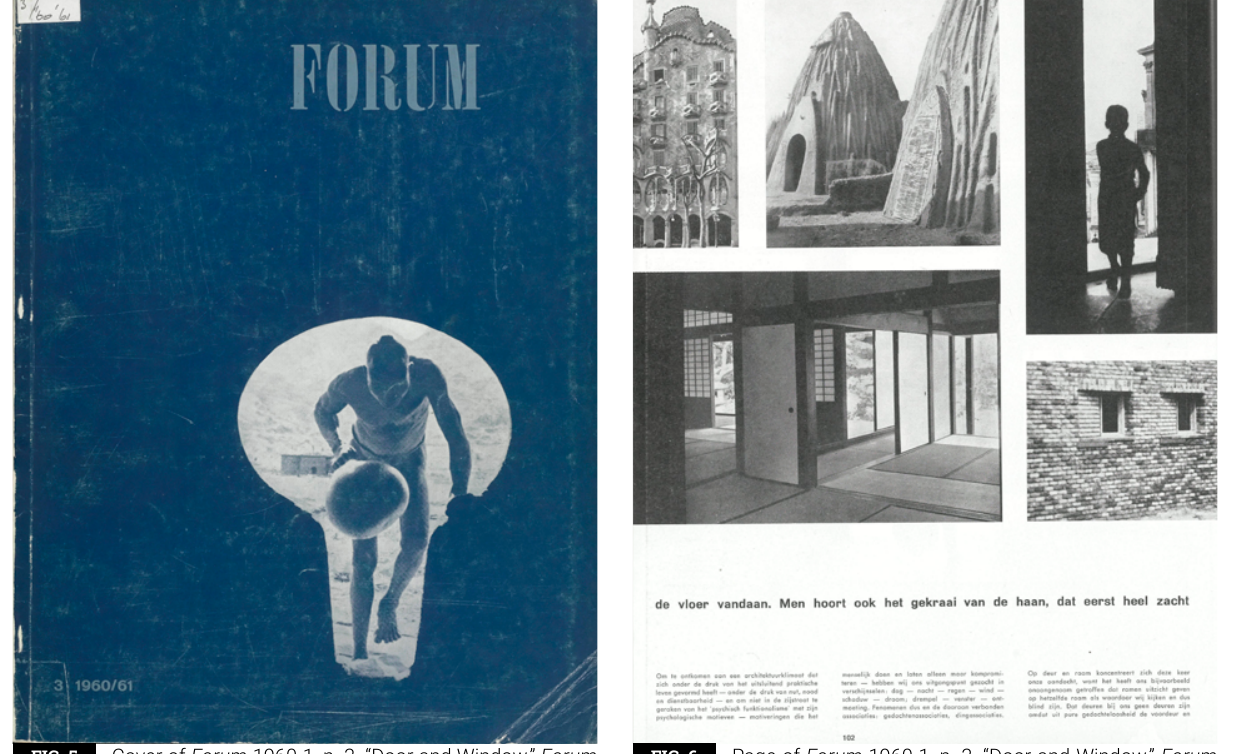
Page of Forum 1960-1, n. 3. “Door and Window.” Forum voor Architectuur en Daarmee Verbonden Kunsten 15, n. 3 (1960-1):